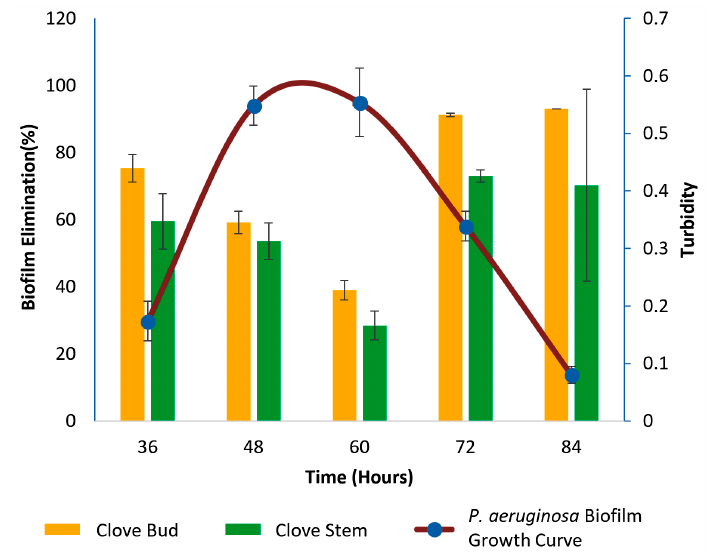
Fig. 4. P. aeruginosa biofilm elimination plotted to biofilm growth curve